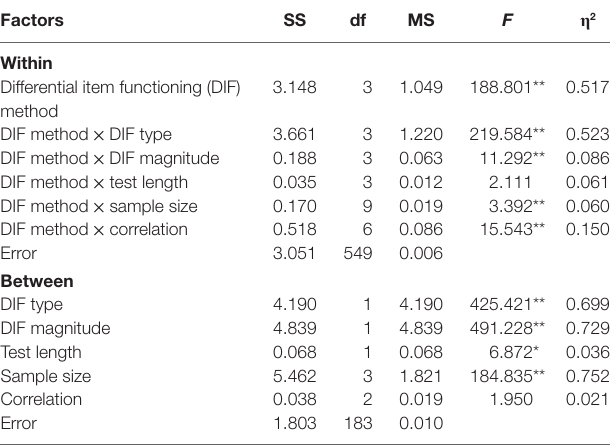
tABLe 4 | Multivariate analysis of variance results for examining the effects of the simulation factors on rejection rates. Factors ss df Ms F η 2